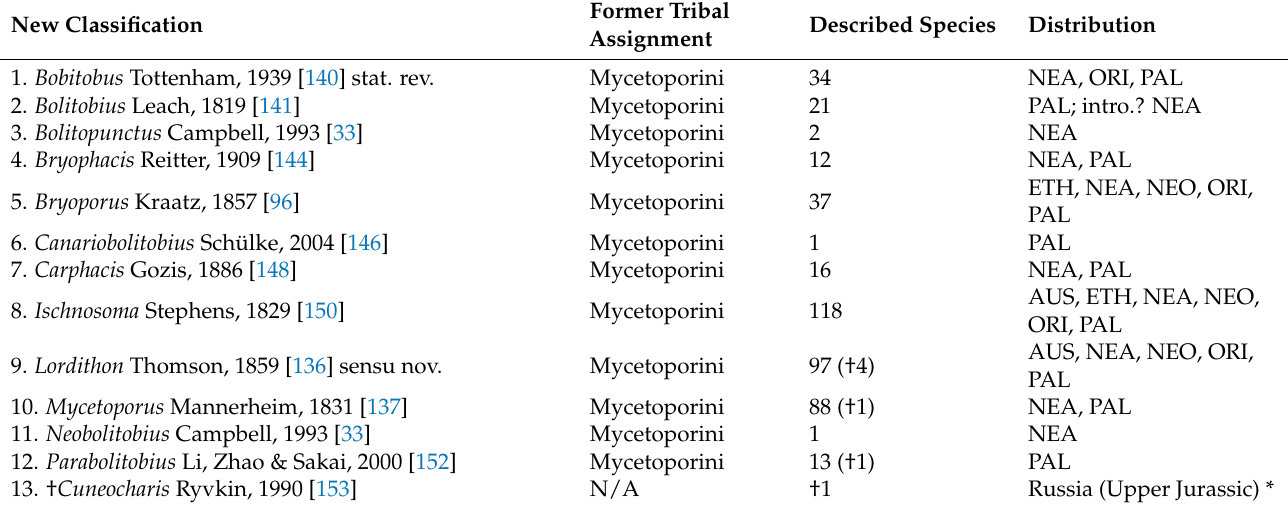
Table A2. General overview of Mycetoporinae stat. nov. (members of the former Mycetoporini in Tachyporinae) under the new